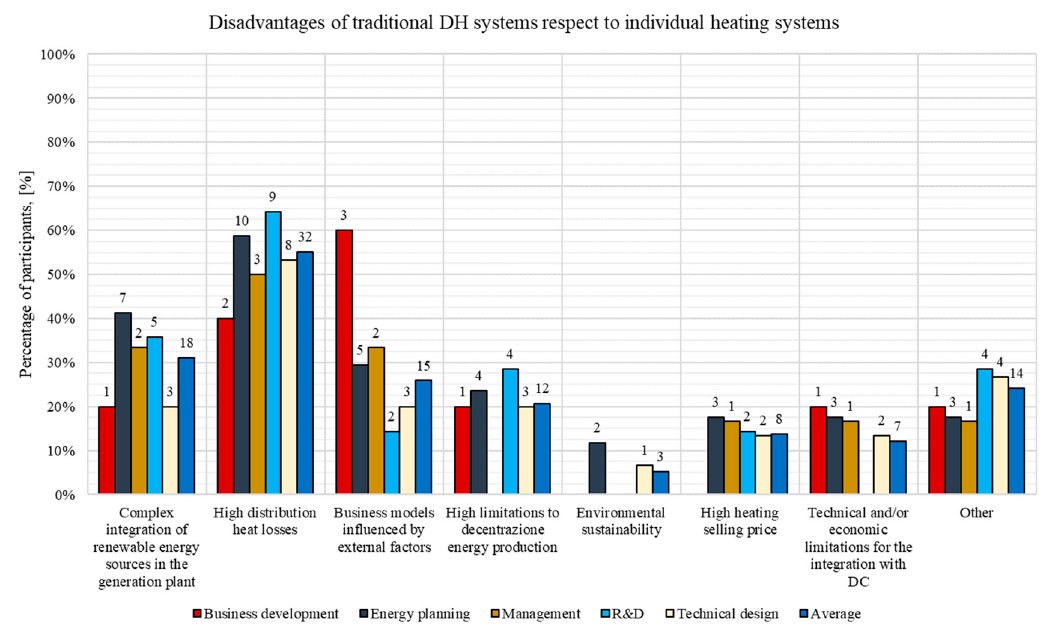
Figure 19. Disadvantages of traditional DH systems with respect to individual heating systems as a function of the employment role.